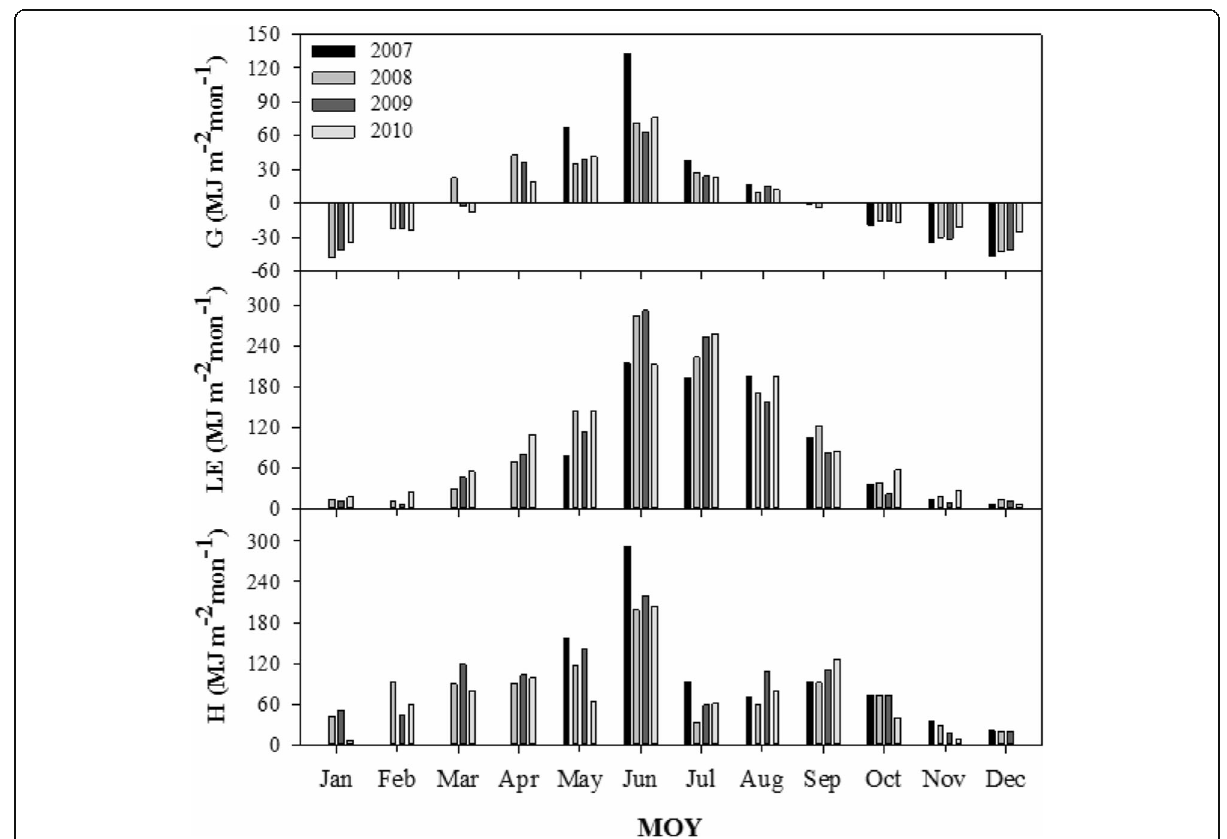
Fig. 4 The monthly change of latent heat (LE), sensible heat ( H ), and soil heat flux ( G ) during 2007 – 2010 in the Songnen meadow steppe in northeastern